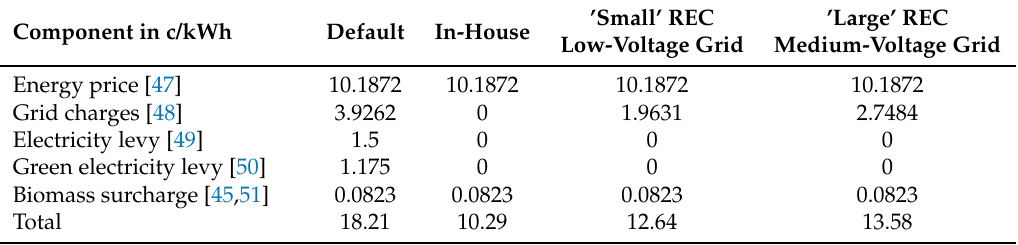
Table 1. Detailed breakdown of electricity costs per kilowatt hour (fixed charges not considered in this table) for different use cases. Energy prices include 6% user fee and 20% VAT. Grid charges include 6% user fee. Total electricity price includes 20%